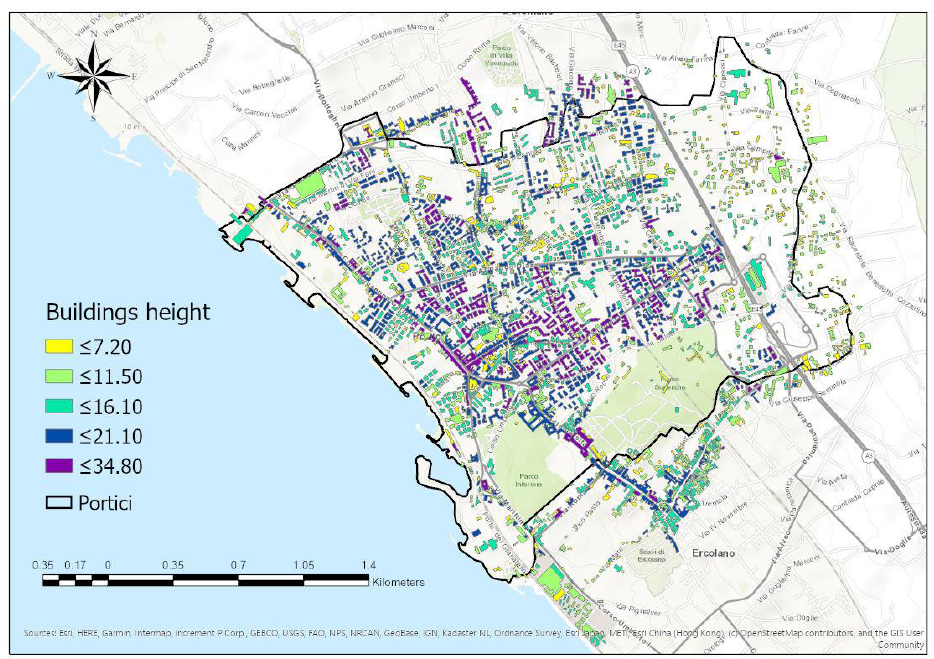
Figure 3. Layer of the building footprint of the city of Portici.